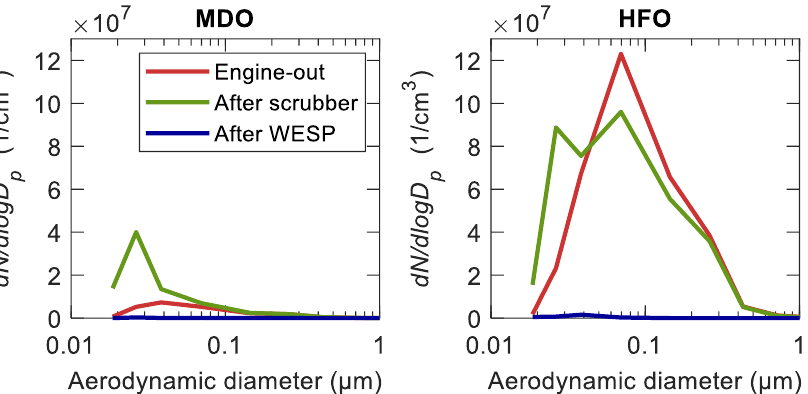
Figure 3. Size distributions of non-volatile particles measured with ELPI and corrected with the dilution ratio from engine-out, after scrubber and after WESP positions. Fuel was MDO in the left figure and HFO in the right figure. The engine load was 50% in both